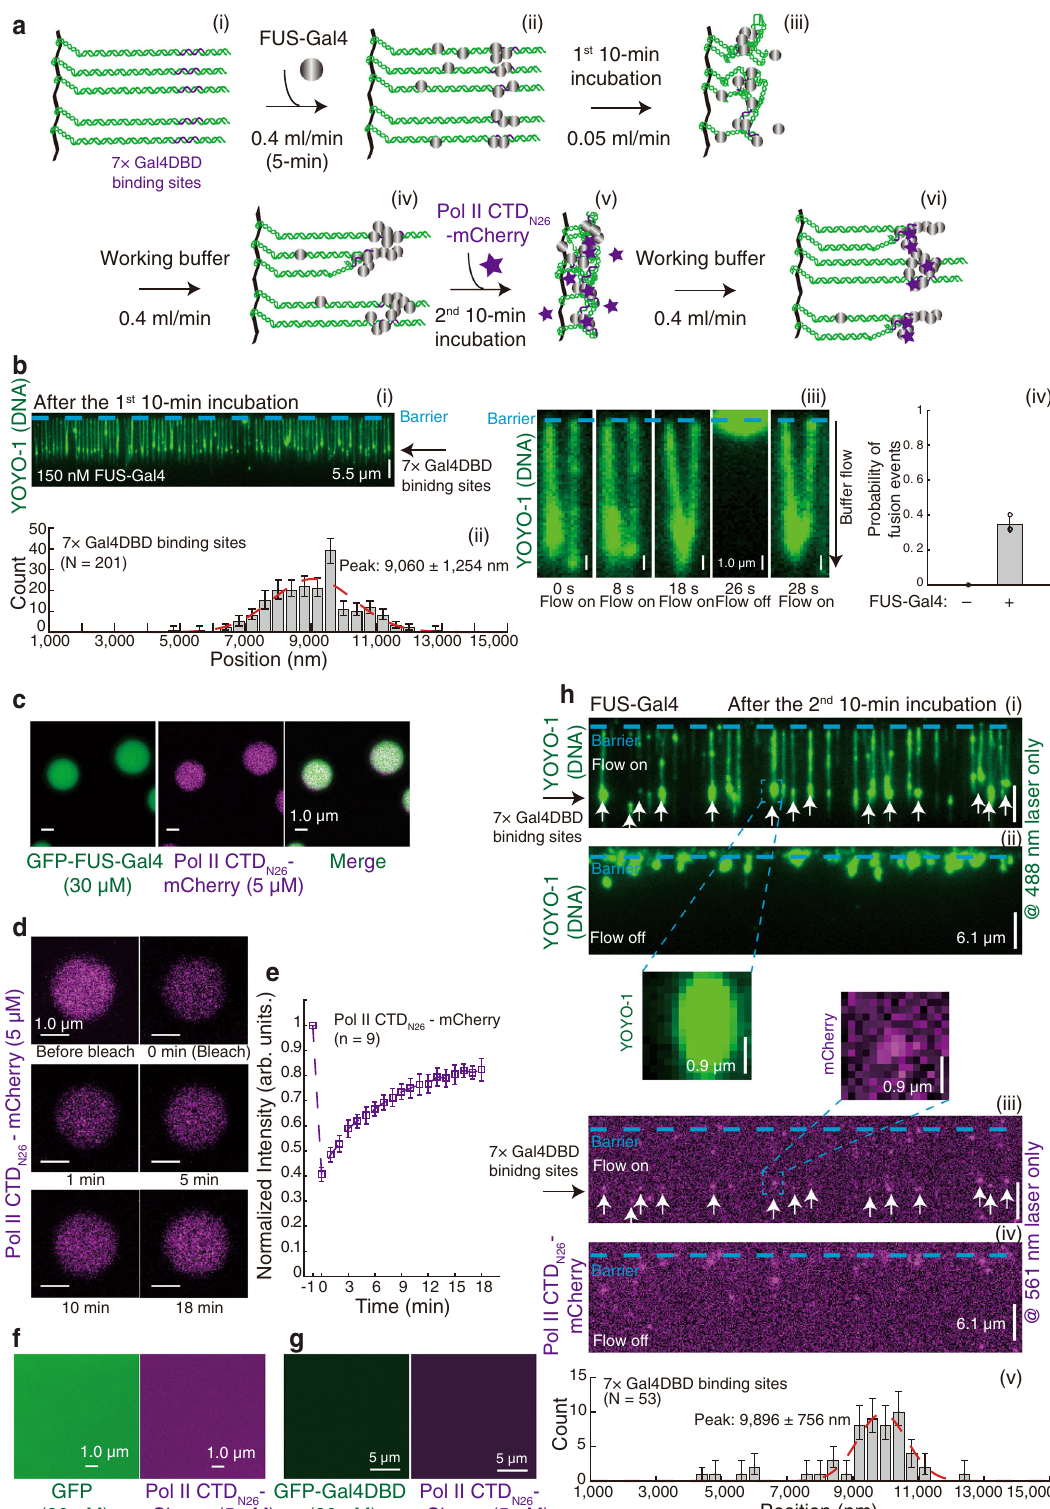
shared the similar threshold feature encoded in a repeated DBD binding-motif. We also performed the control experiment without co-transfection of the fusion proteins (Fig. 5d). There was little luciferase activity observed without the fusion protein, further supporting that the fusion protein is responsible for the increased transcription of these longer GGAA